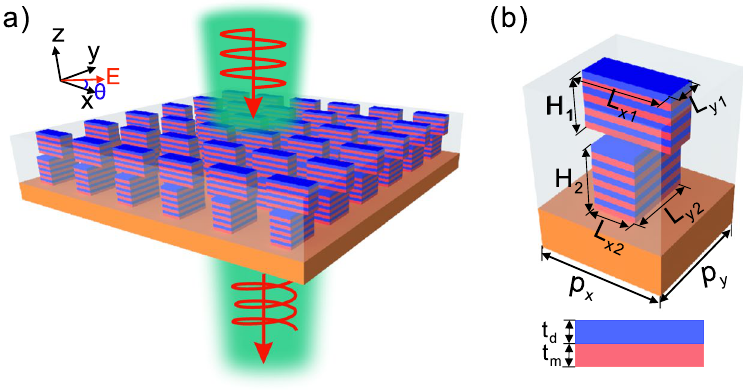
Figure 2. Double-stacked HMM waveguide arrays. Schematic illustrations of ( a ) double-stacked HMM waveguide arrays and ( b ) the unit cell. The HMM waveguide arrays are placed on the HDPE substrate and the surrounding material is BCB. The unit cell consists of two HMM waveguides, of which the upper (lower) one has length L x1 (L y2 ), width L y1 (L x2 ) and height H 1 (H 2 ). The lattice constants along x and y directions are p x and p y , respectively. t m and t d represent the thicknesses of the metal and dielectric layers, respectively. A normal incident plane wave illuminates the structure from the –z direction with the polarization angle θ relative to the